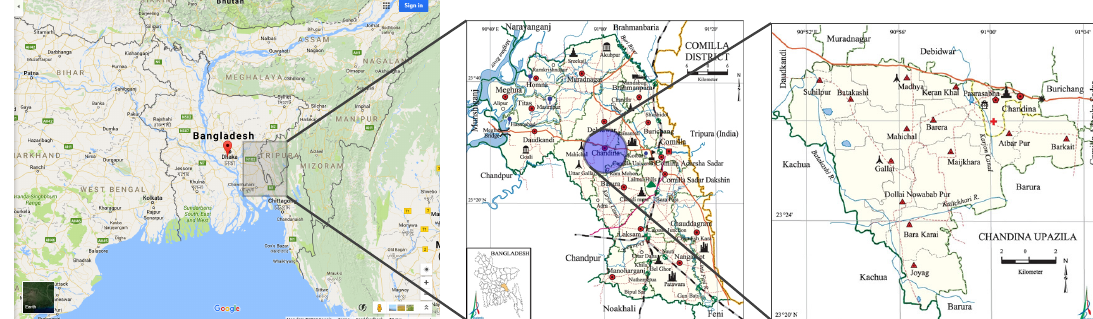
Figure 1. Chandina sub-district of Cumilla district in Bangladesh (from left to right, not to scale). Compiled from References